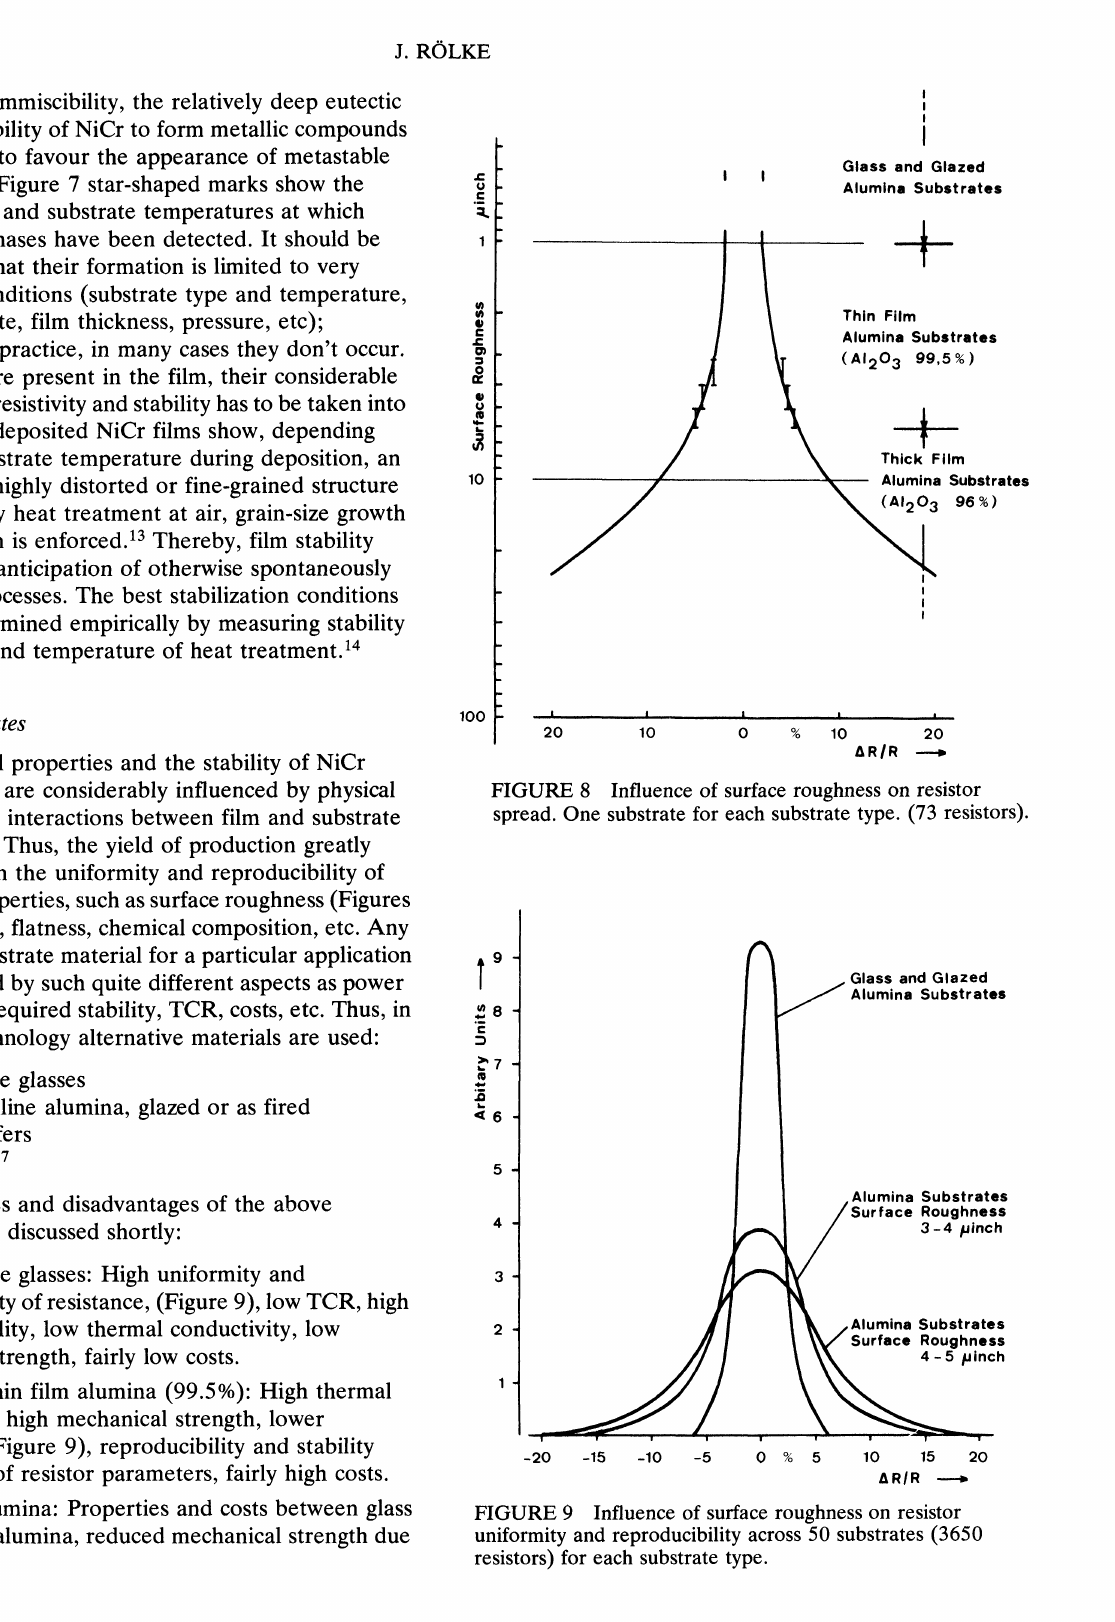
FIGURE 9 Influence of surface roughness on resistor uniformity and reproducibility across 50 substrates (3650 resistors) for each substrate